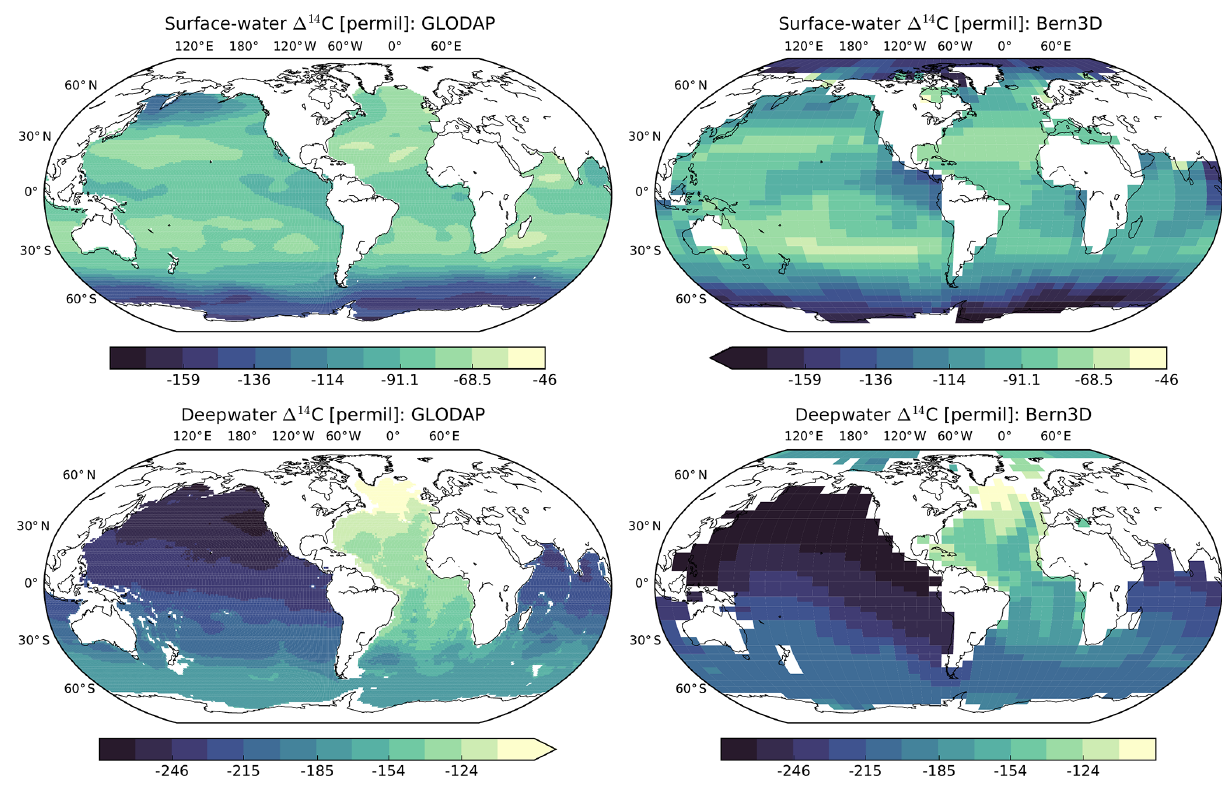
Figure 3. Steady-state distribution of (cid:49) 14 C in the surface ( < 100m) and deep ( > 1500m) ocean for the preindustrial control run (right) compared to the distribution of (cid:49) 14 C based on the Global Ocean Data Analysis Project